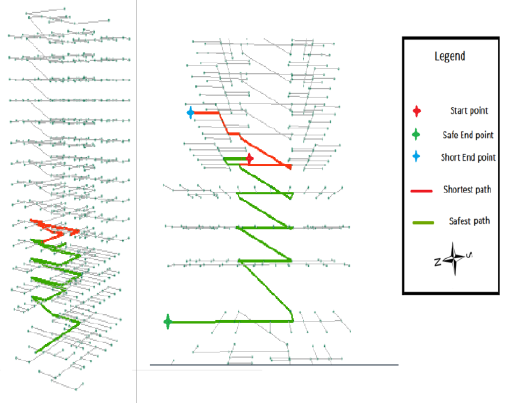
Figure 12. Scenario No. 11-Shortest and safest